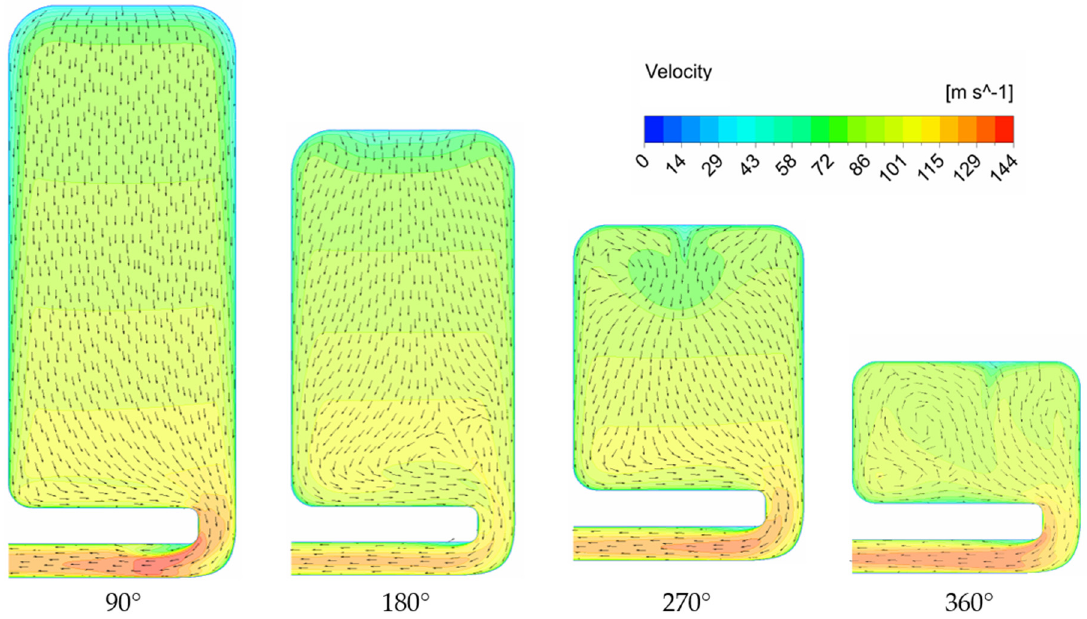
Figure 4. Velocity contours and vectors in selected cross-sections of the scroll distributor.